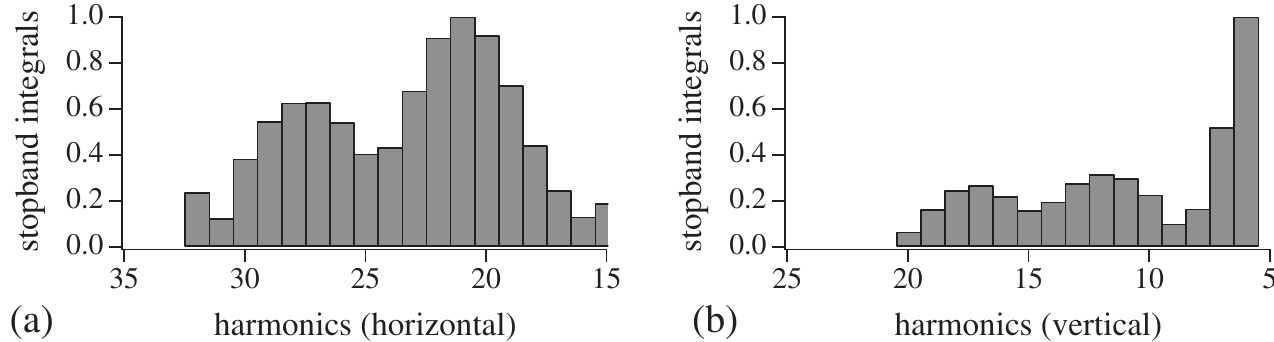
FIG. 6. (a) Horizontal and (b) vertical stopband integrals of a lattice with the same alignment errors as Fig.